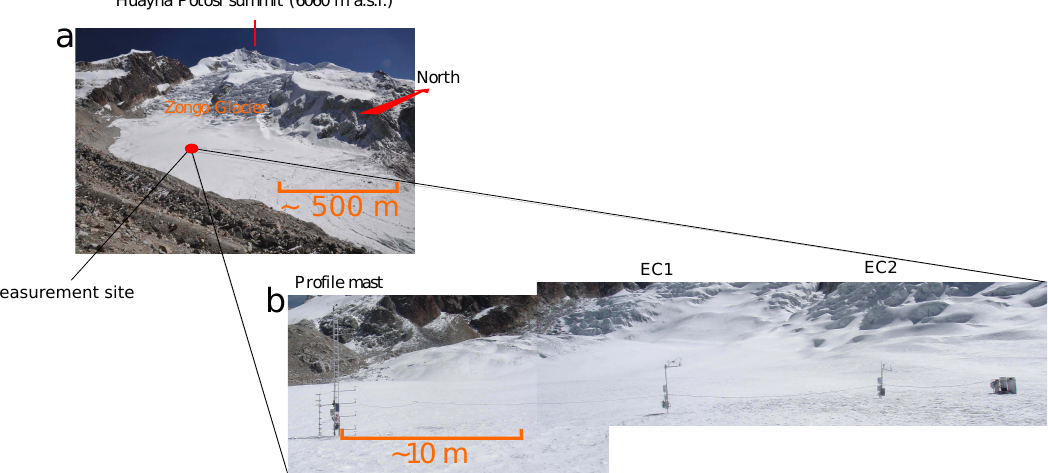
Figure 1. Overview of Zongo Glacier and the instrumental set-up deployed during the 2007 dry season campaign. (a) Picture of the glacier, taken from the moraine at 5080ma . s . l . The red circle indicates the location of the measurement site. (b) Picture of the profile mast and the eddy-covariance (EC) systems. The automatic weather station, located behind the photographer, is not